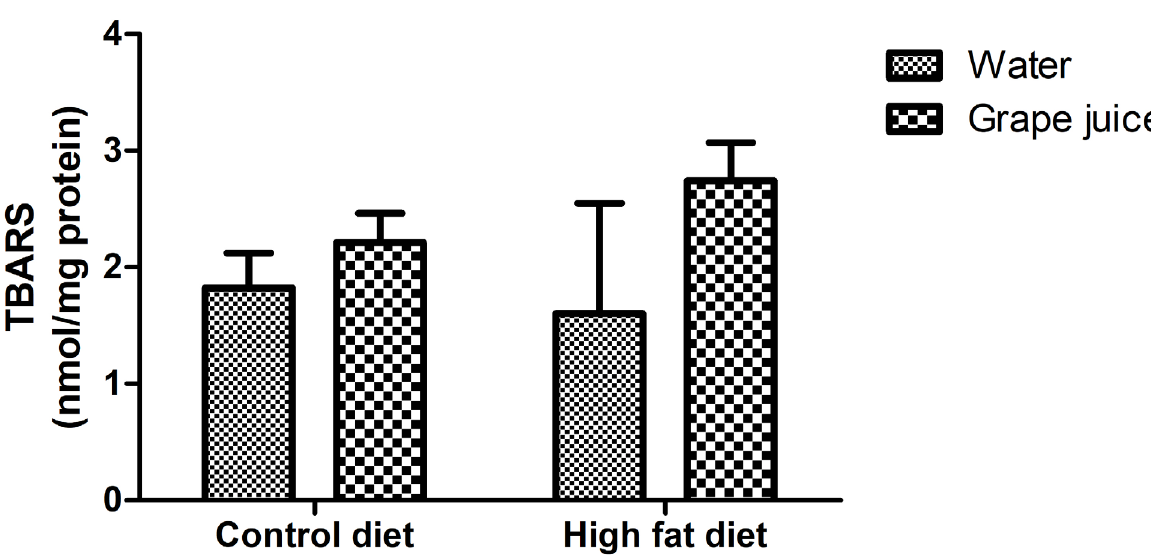
Figure 3. TBARS levels (nmol / mg) expressed as mean ± standard error of the mean in female pups hippocampus of Wistar rats treated with purple grape juice during the gestational period. Statistical analysis using two-way ANOVA, followed by Tukey‘s after